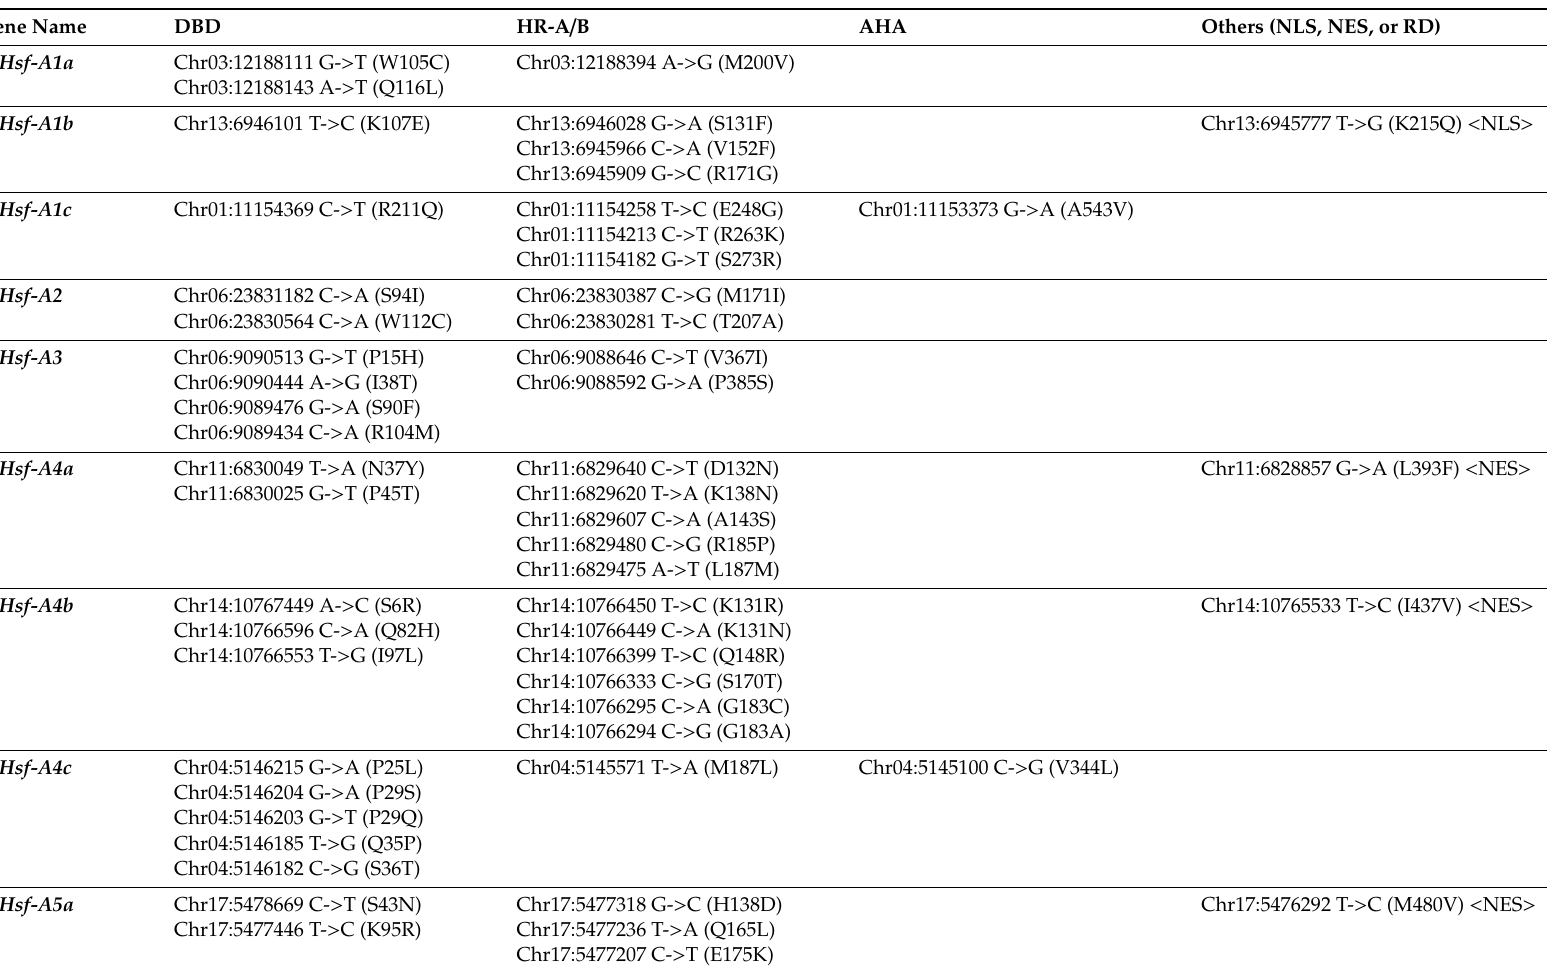
Table 3. The non-synonymous coding single nucleotide polymorphisms (SNPs) located in the domain of PtHsfs